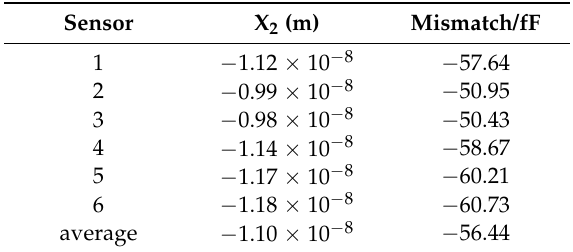
Table 2. Mismatch of different sensors on same